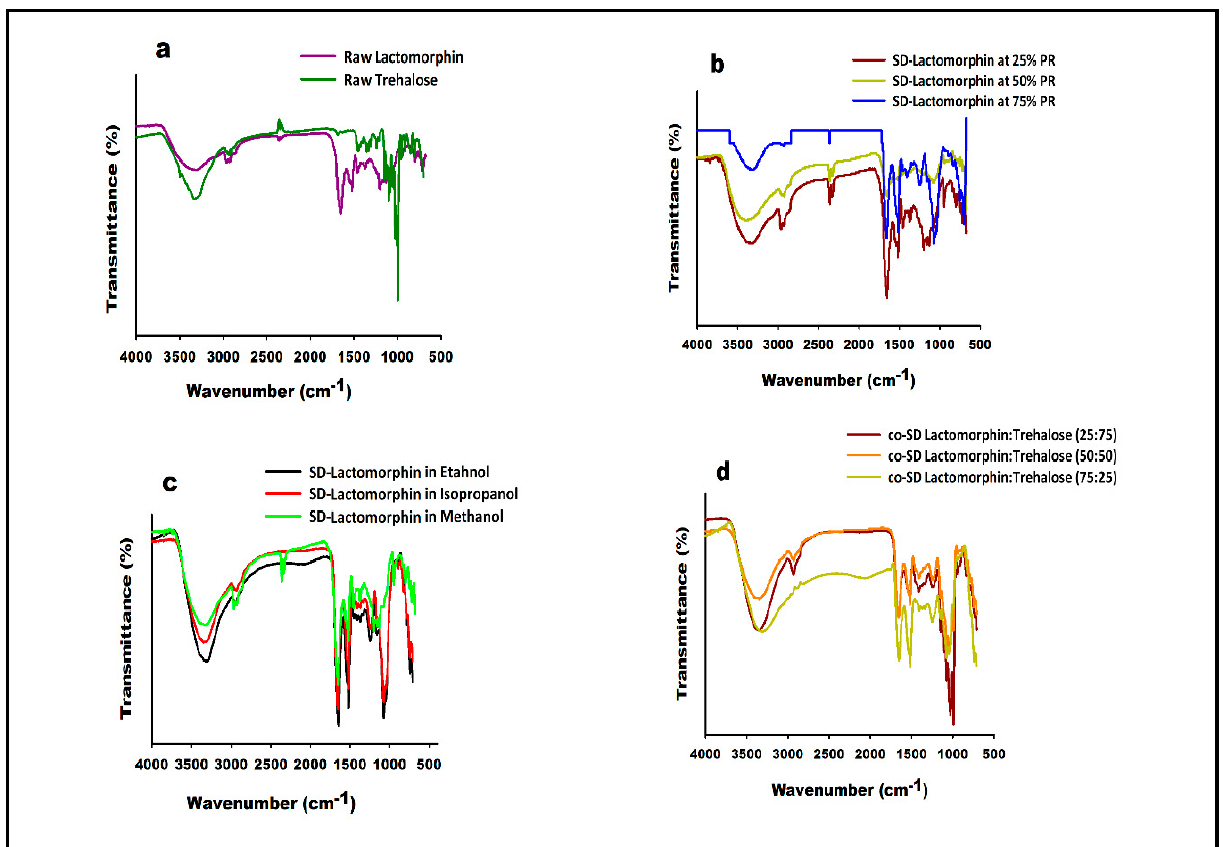
Figure 6. ATR-FTIR spectra of ( a ). Raw Lactomorphin and and raw Trehalose; ( b ). SD-Lactomorphin samples in methanol at different PR; ( c ). SD-Lactomorphin samples from two different feed solvents at 25% PR; ( d ). co-SD-Lactomorphin:Trehalose at different molar ratios in methanol at 25%